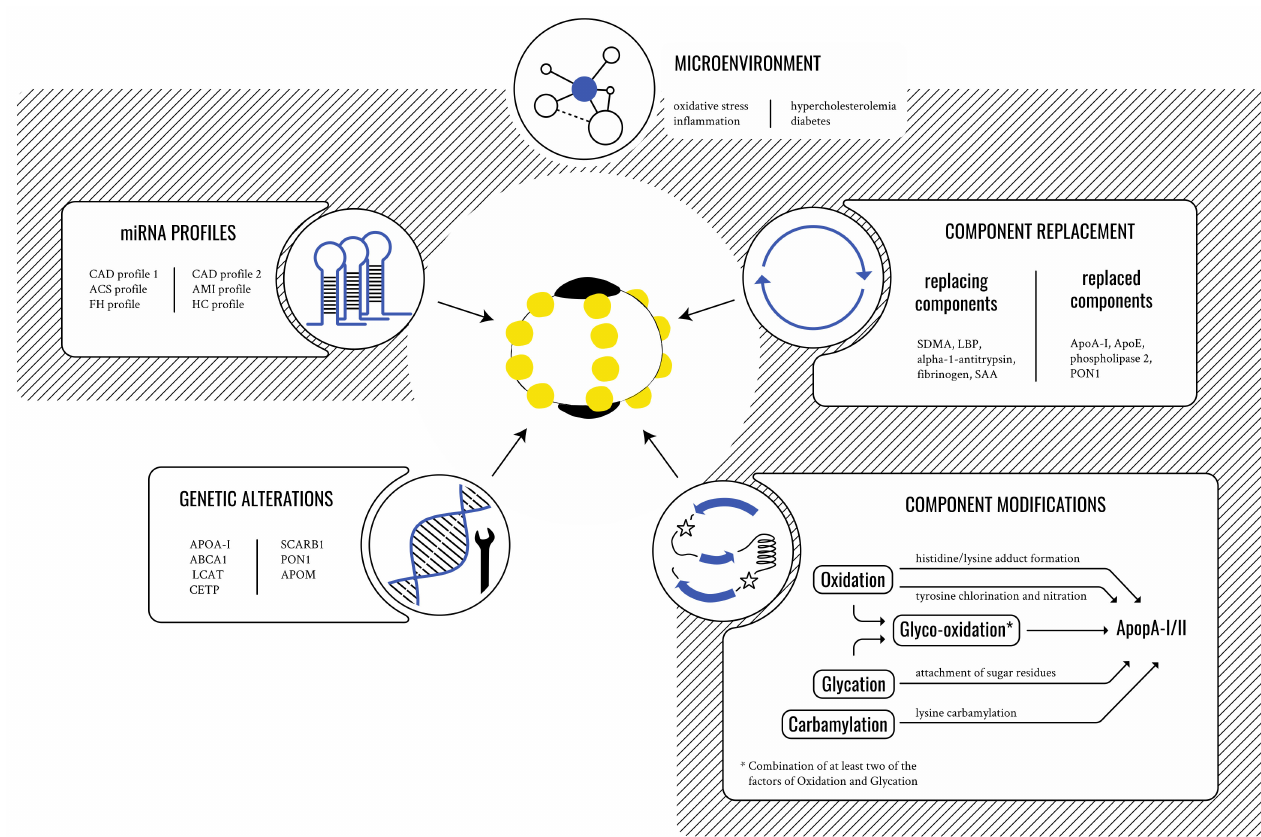
Figure 2. Characteristics and influencing factors of dysfunctional HDL